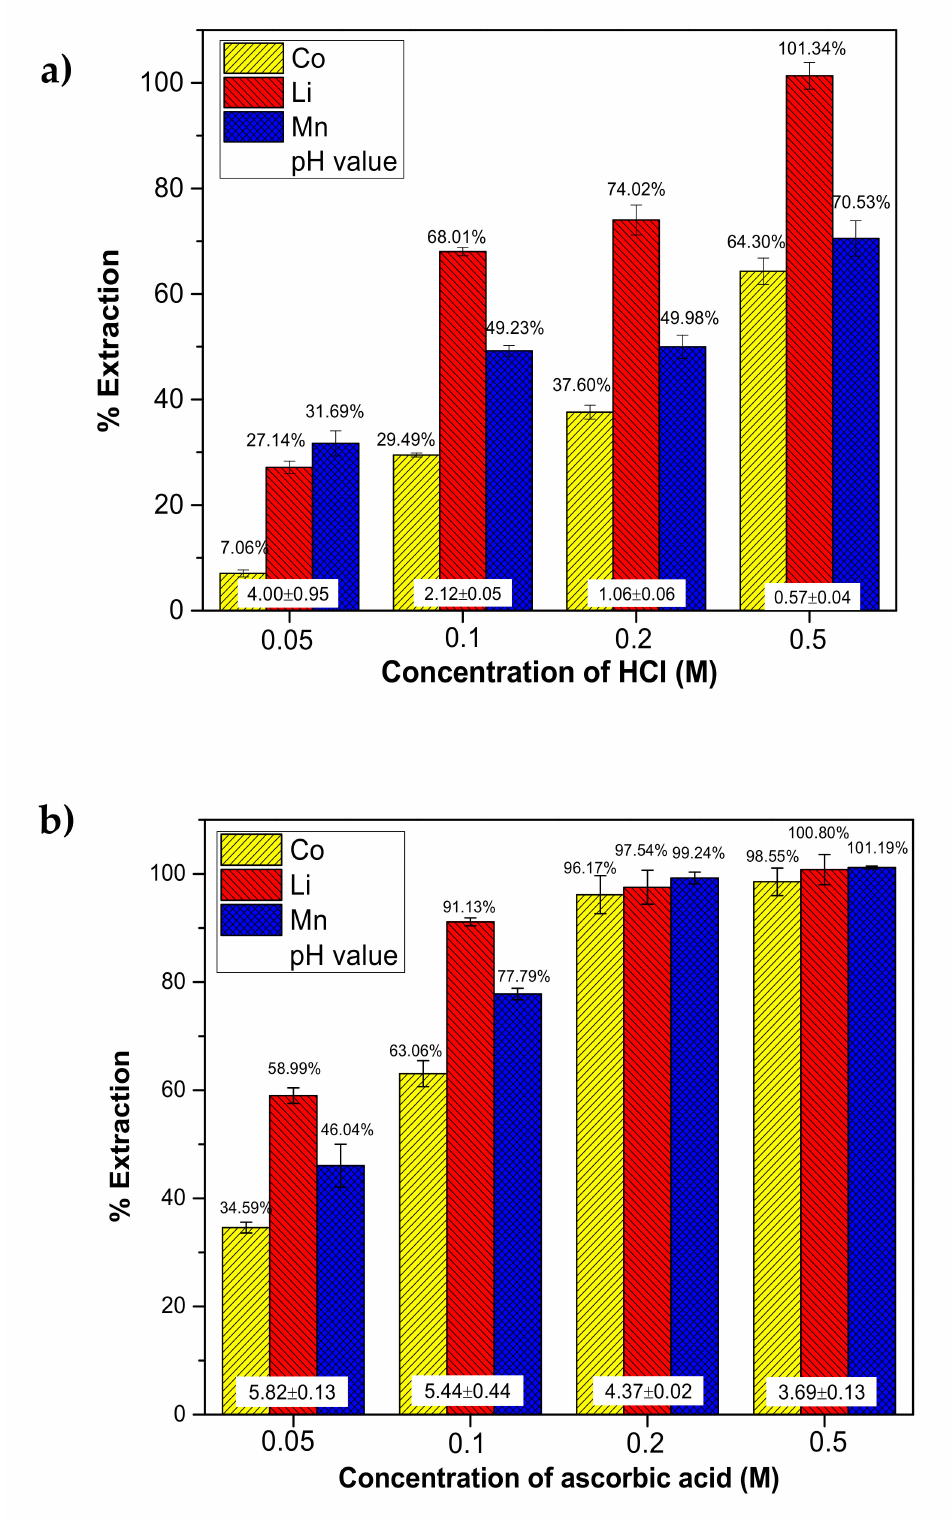
Figure 1. E ff ect of concentration on subcritical water extraction (SWE) at 100 ◦ C, 10 bar, and solid-to-liquid (S / L) ratio of 10 g / L for 30 min using ( a ) HCl and ( b ) ascorbic acid. The stoichiometric concentrations of HCl and ascorbic acid to leach Li, Co, and Mn from 10 g / L of spent LIBs were 0.4 M and 0.2 M. However, when using 0.5 M of HCl, S / L of 10 g / L, 100